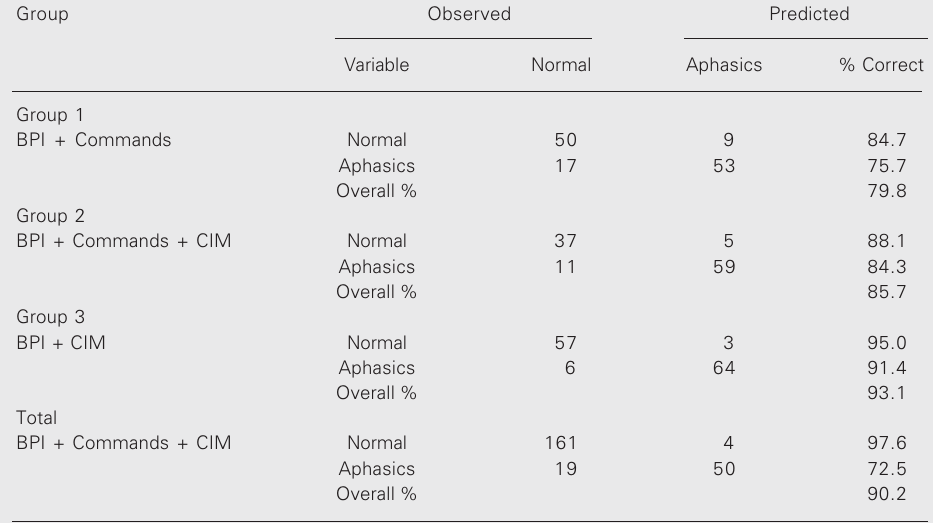
Table 8. Results of logistic regression.